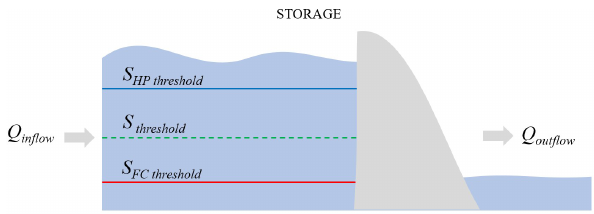
Figure 3. Schematic representation of the dynamic storage thresh- old ( S threshold ), represented by the green line. S threshold can range between the blue line, which represents the target storage to opti- mize hydropower production ( S HP ), and the red line, which threshold represents the target storage to avoid flood damages downstream of the dam ( S FC threshold